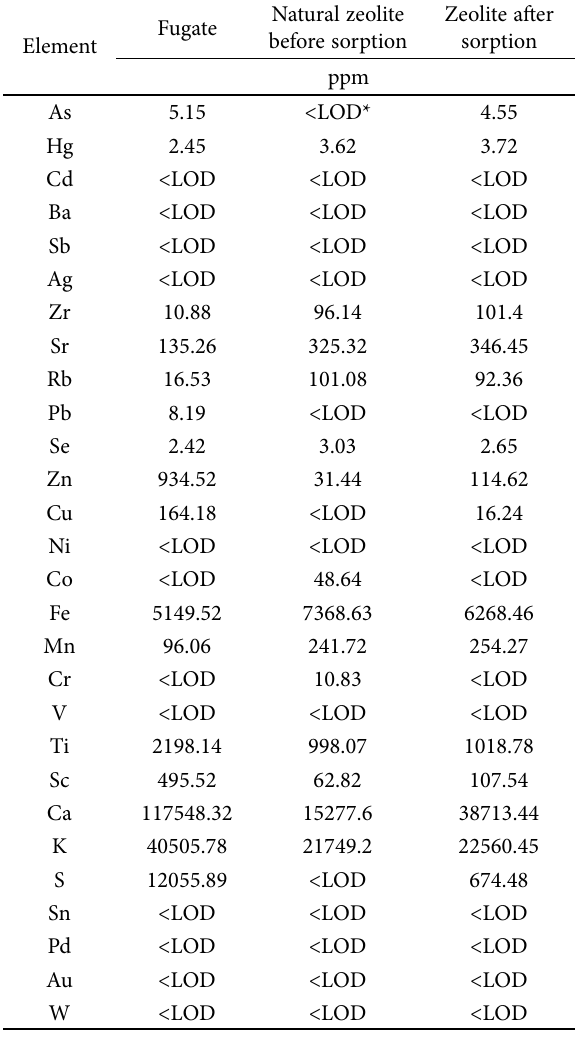
Table 7. Composition of elements in substances Natural Fugate Element